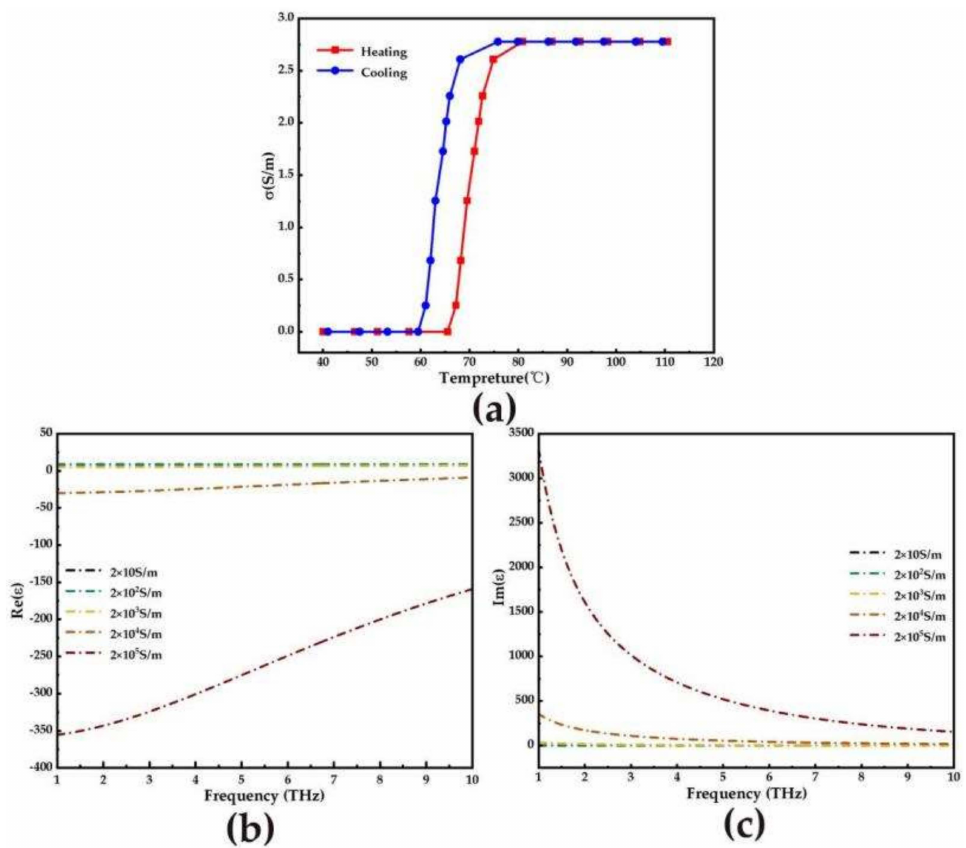
Figure 2. ( a ) The curves of the conductivity of the VO 2 with ambient temperature; ( b , c ) the real and imaginary parts of the relative permittivity of VO 2 at diverse conductivities.